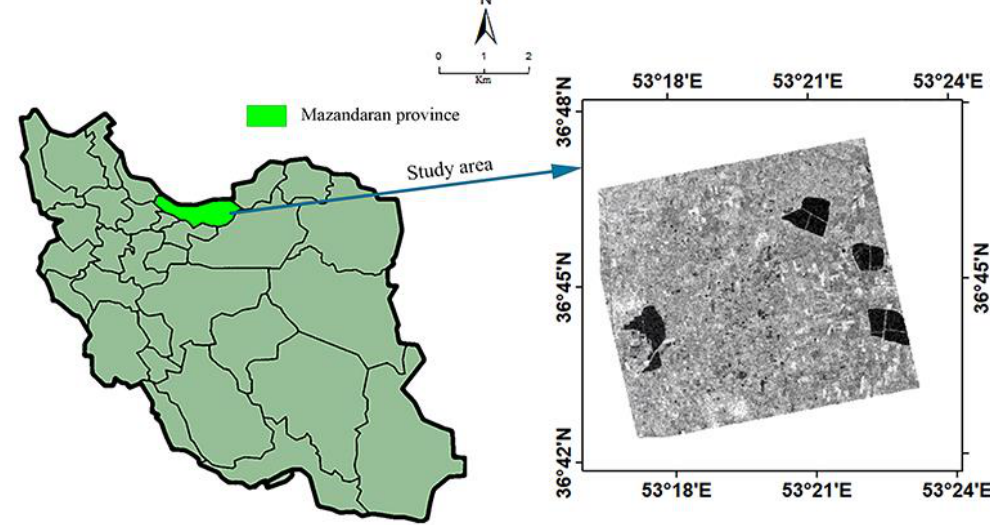
Figure 1. Study area and location of the field survey sites in the Mazandaran province,